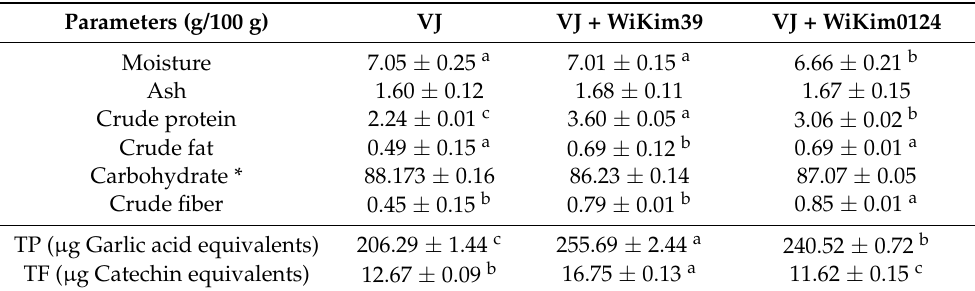
Table 1. Proximate composition, TP and TF content of non-fermented or fermented vegetable juice with